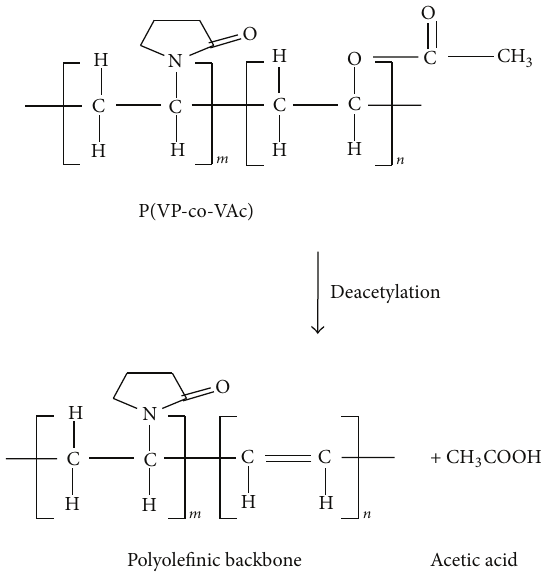
Figure 5: Deacetylation of PVAc—the second degradation stage of P(VP-co-Vac).